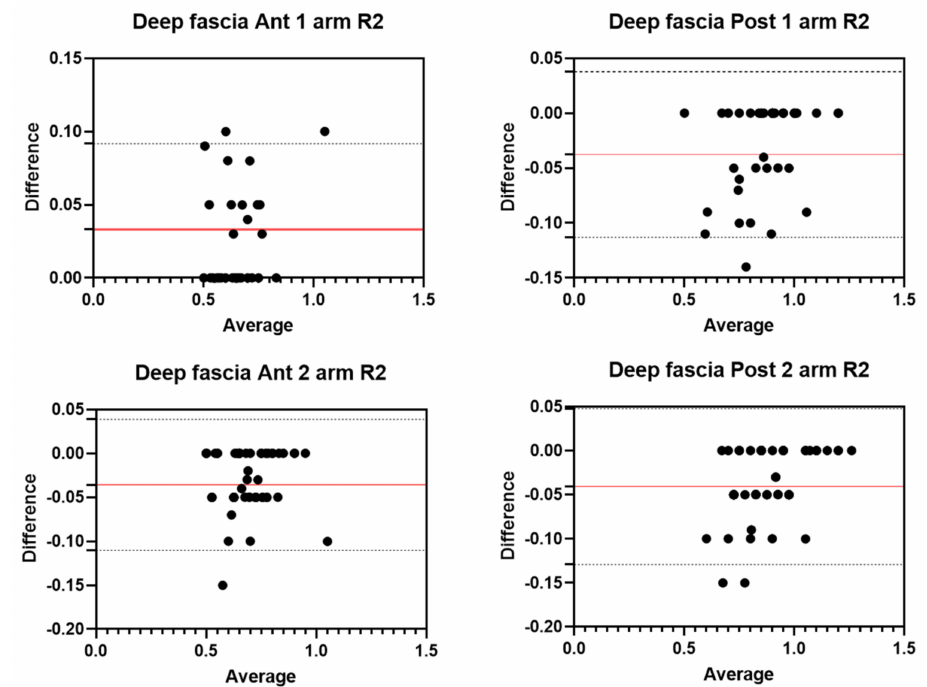
Figure 4. Bland–Altman plot comparing two sessions of Rater 2 (R2) measuring the US thickness of the deep fascia of the arm for the different levels. Red line = bias or mean difference; dashed lines: 95% limits of agreement (LoAs).